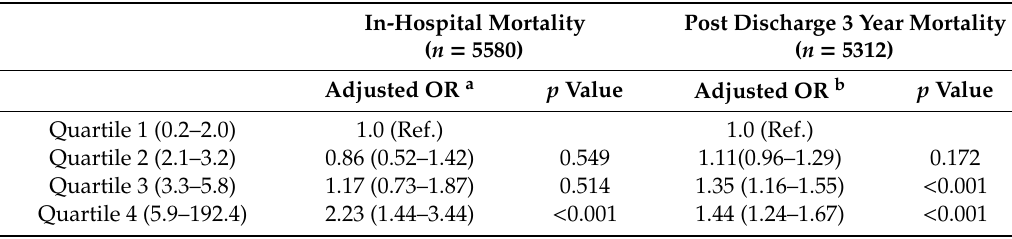
Figure 1. Overall in-hospital mortality and 3-year survival after discharge. Quartile 1 (0.2–2.0); Quartile 2 (2.1–3.2), Quartile 3 (3.3–5.8), Quartile 4 (5.9–192,4). Table 2. Univariate and multivariate logistic regression analyses for all-cause in-hospital and Cox regression analysis for post discharge three-years mortality in HF patients stratified by quartiles of neutrophil to lymphocyte ratio at admission. HF, heart failure; NT-proBNP, n-terminal brain natriuretic peptide; HFrEF, heart failure with reduced ejection fraction; HFmrEF, heart failure with mid-range ejection fraction; HFpEF, heart failure with preserved ejection fraction; BNP, brain natriuretic peptide; AA, aldosterone antagonist; BB, beta blocker; RASi, renin-angiotensin system